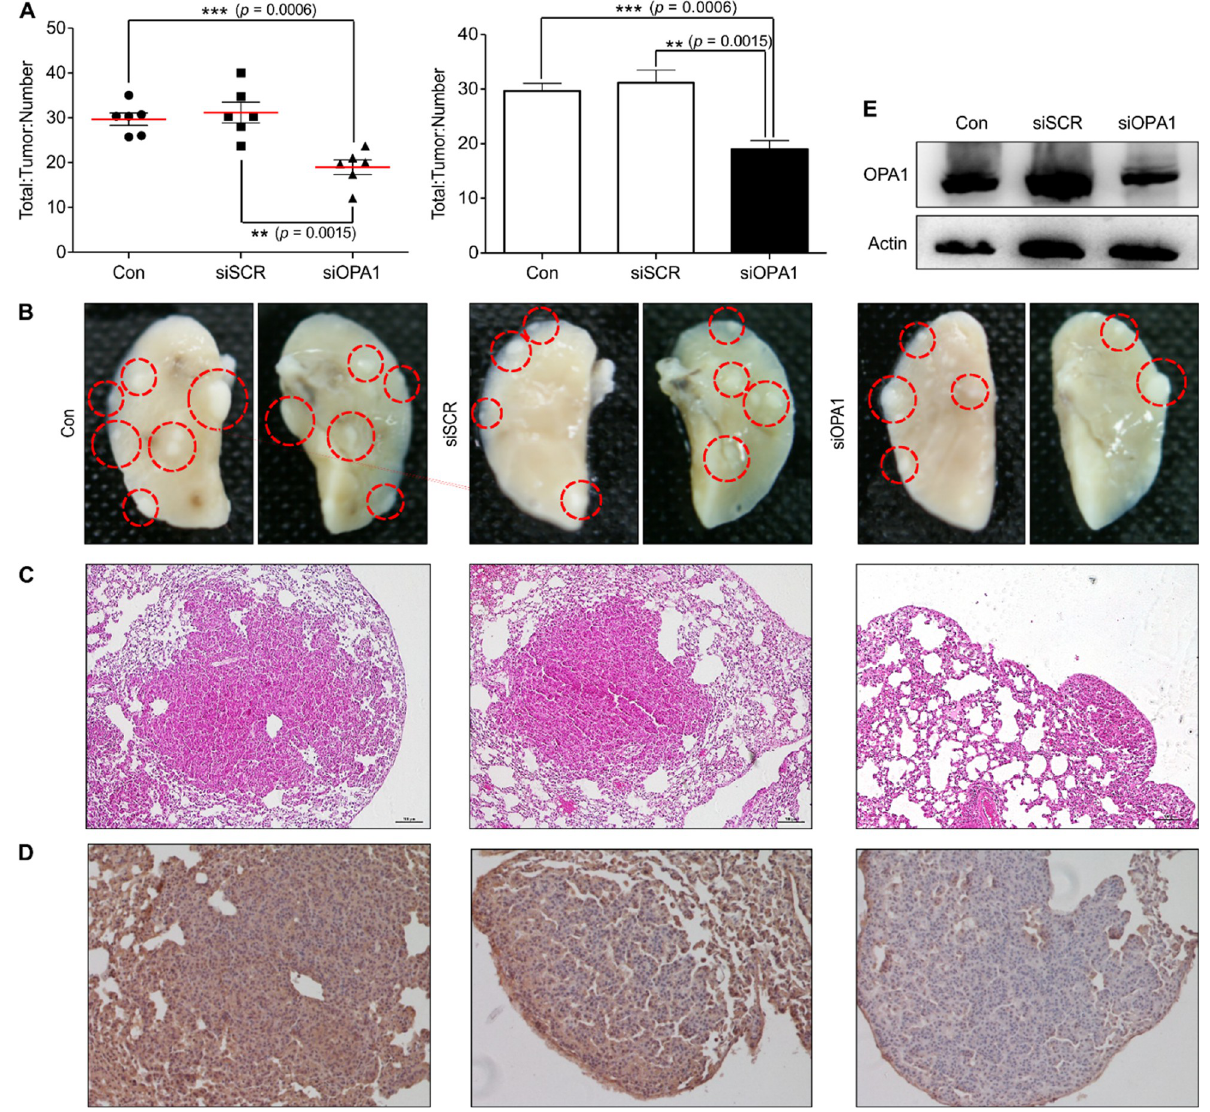
Fig 4. Therapeutic efficiency of FPS as aerosol gene delivery carrier in lung tumor bearing K-rasLA1 mice. Aerosol delivery FPS/siOPA1 significantly inhibited lung tumor numbers; (A) A decrease in the number and size of tumor nodules were found during gross morphological observations. (B) The total number of tumors decreased significantly in the FPS/siOPA1-delivered group. (red circle represents tumor tissues). (C) The control group and FPS/siSCR group showed severe thickening of alveolar septa with invasive growth and loss of normal lung structure, whereas the FPS/siOPA1 group showed a smaller tumorigenic region. (D) Immunohistochemistry reconfirmed downregulation of OPA1 in tumor-bearing lungs of FPS/siOPA1-delivered mice. (E) Western blot analysis of OPA1 protein expression in the lungs and bands-of-interest were further analyzed by densitometer, confirmed down-regulation of